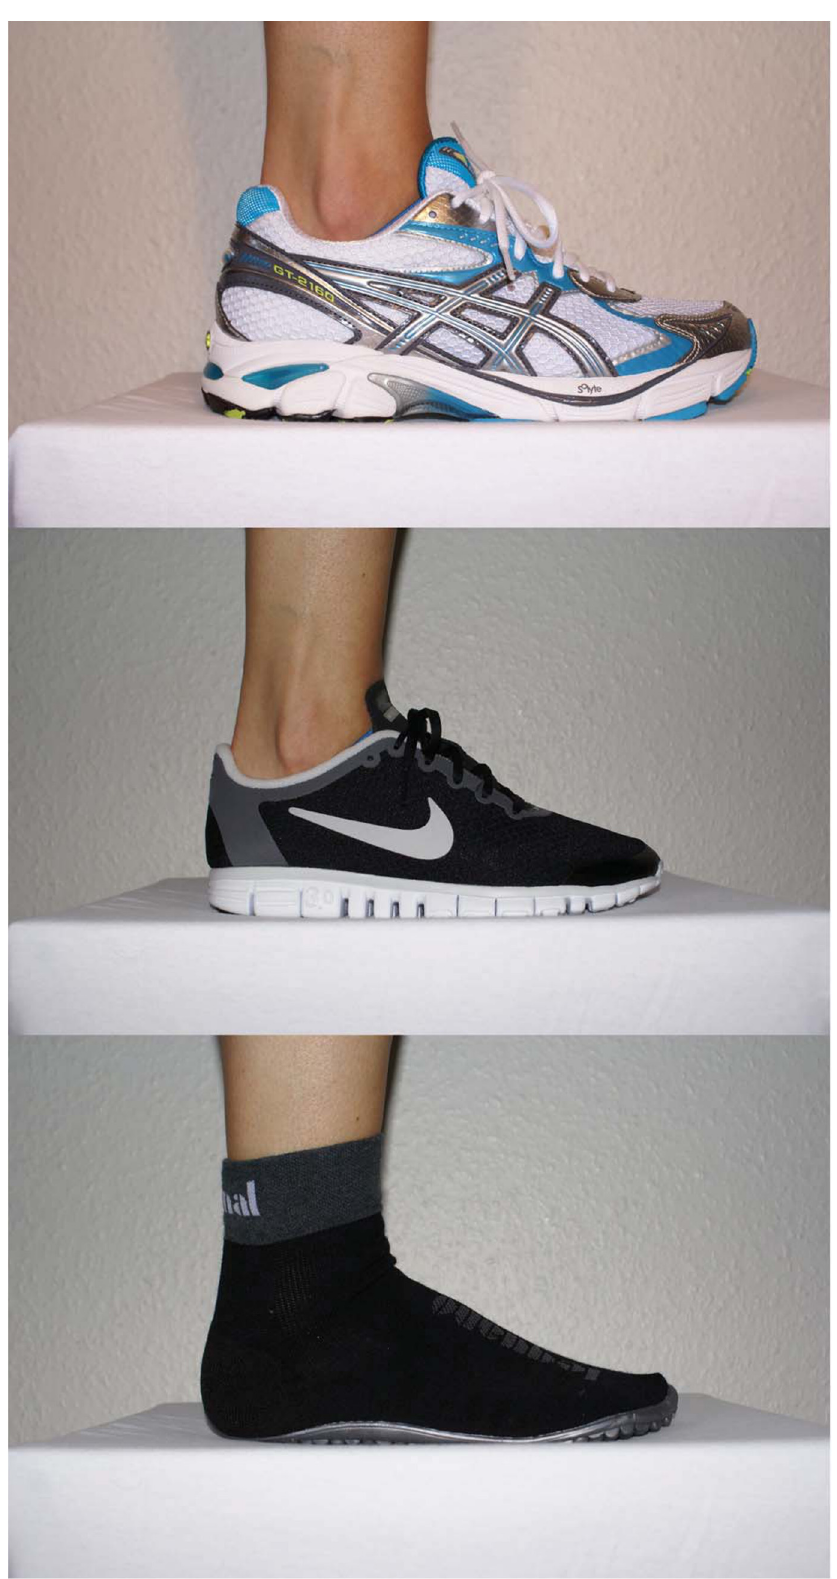
Fig 1. Shoe conditions. (top image = Asics GT-2160, center image = Nike free 3.0, lower image = Leguano).